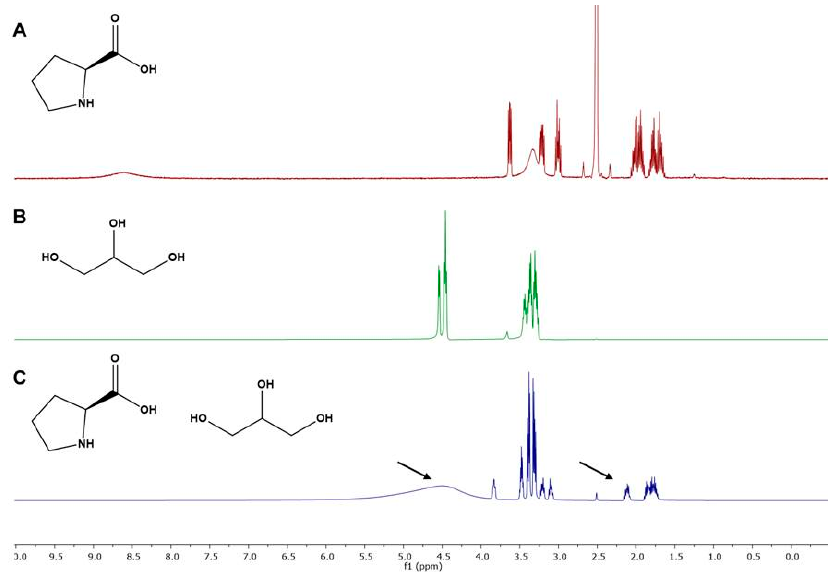
Figure 5. 1 H-NMR spectra of ( A ) L -proline, ( B ) glycerine and ( C ) N16 (20% w/w of water).